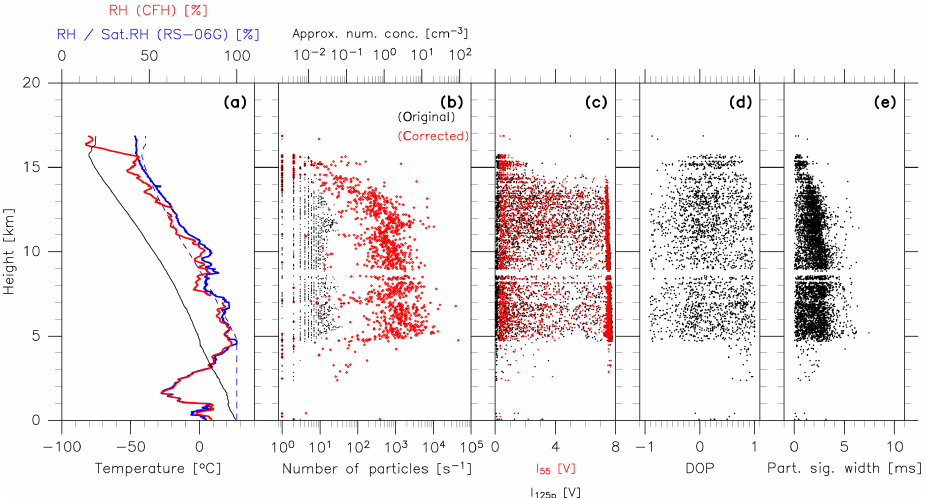
Figure 8. As for Fig. 6, but for the profiles taken at Biak, Indonesia, launched at 18:00LT on 23 February 2015. In panel (a) , data from the RS-06G radiosonde are plotted, and RH from the CFH (red) is also